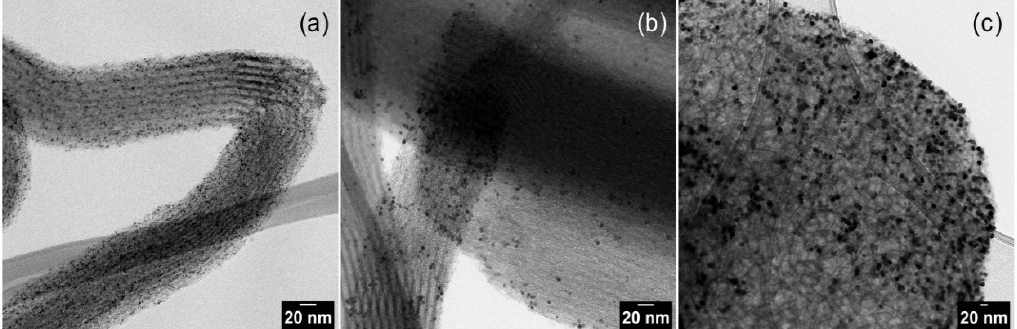
Figure 2. TEM images of Pt nanoparticles dispersed on silica supports: ( a ) 2 nm Pt on SBA-15; ( b ) 4 nm Pt on SBA-15; and ( c ) 8 nm Pt on MCF-17. Table 1. Textural properties and Pt loadings of SBA-15 and MCF-17 supported catalysts.